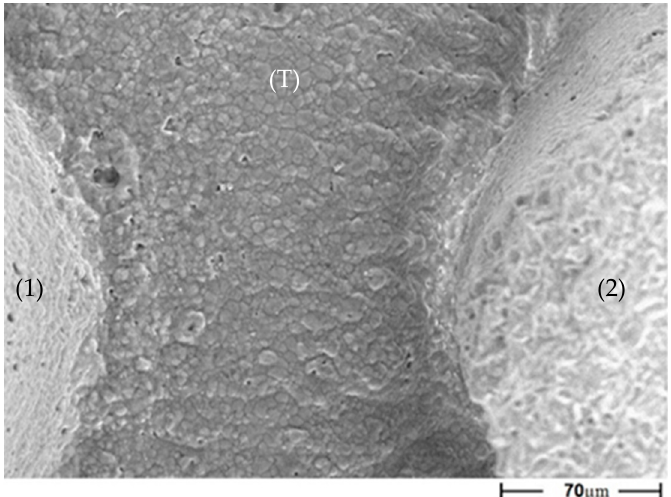
Figure 4. SEM image showing the contact area between interconnecting rods of adjacent layers.